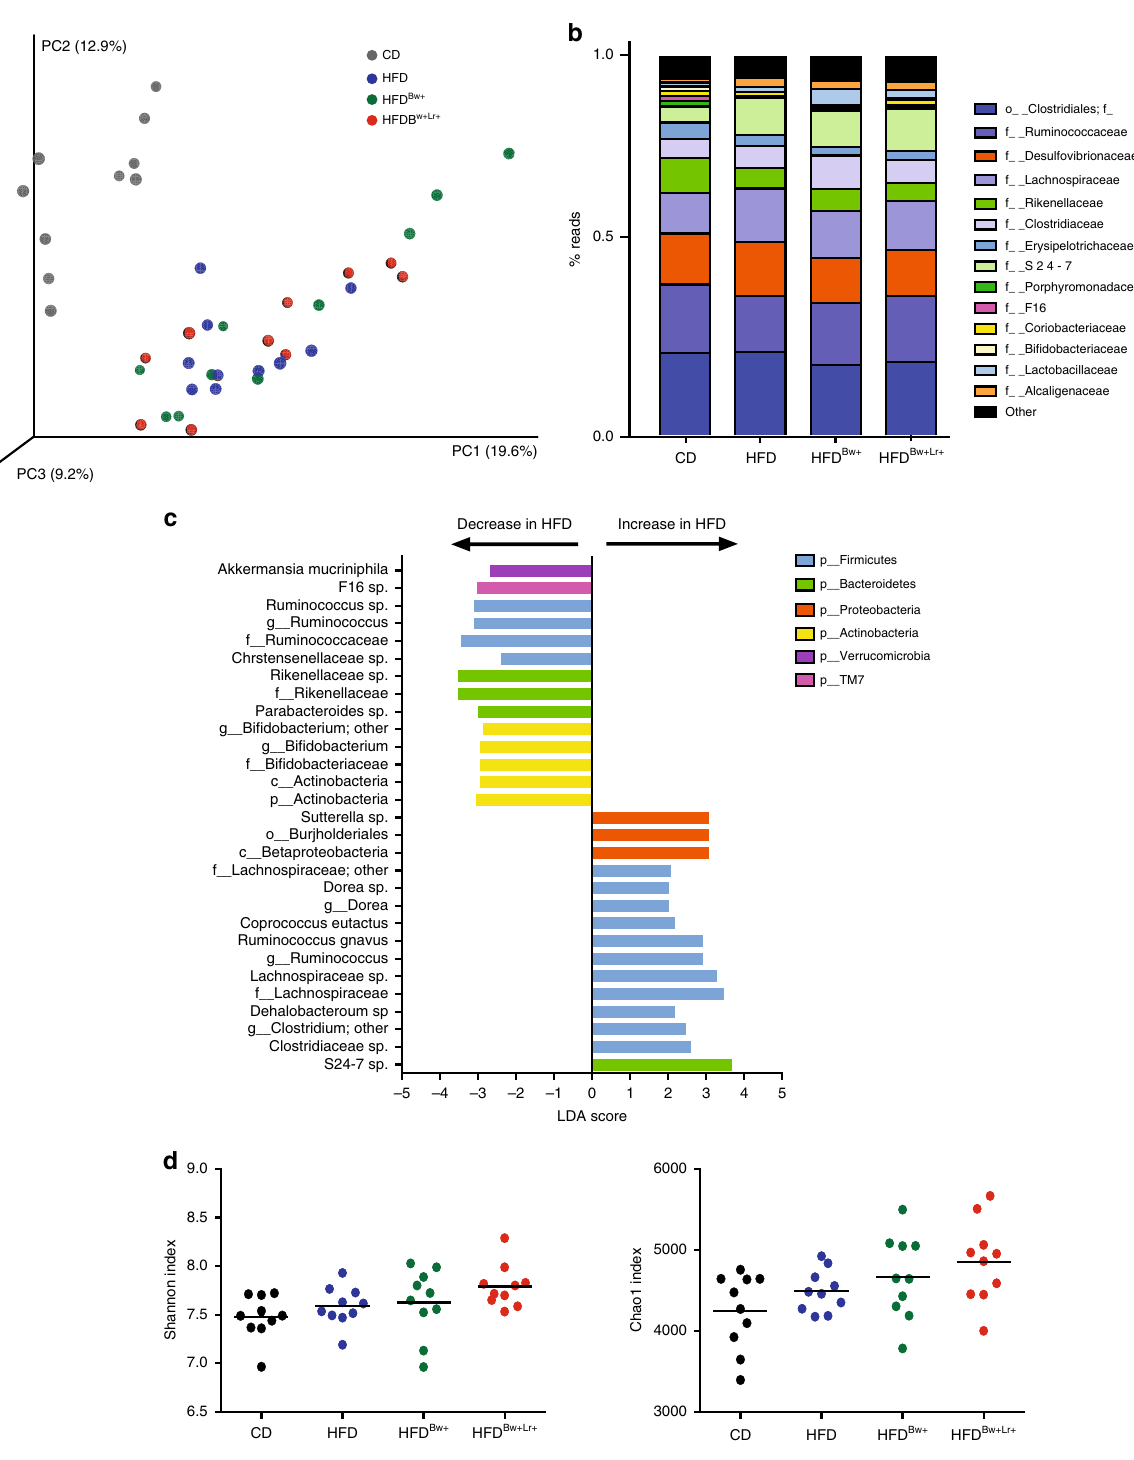
Fig. 3 HFD induces signi fi cant impact on microbiota composition. a PCoA plot (Bray Curtis distance) of fecal microbiota of CD-fed or HFD-fed mice inoculated with or without B. wadsworthia (Bw) and/or L. rhamnosus CNCM I-3690 (Lr) on Bray Curtis distance. b Bar graph of bacterial abundance